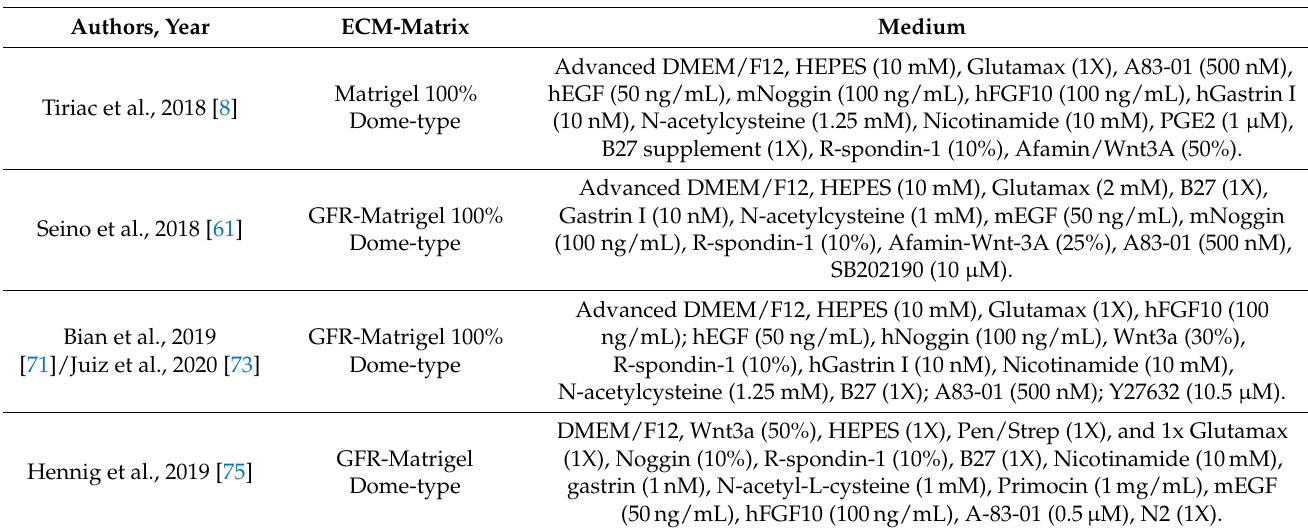
Table 3. Methods to culture organoids from human PDAC using EUS-guided